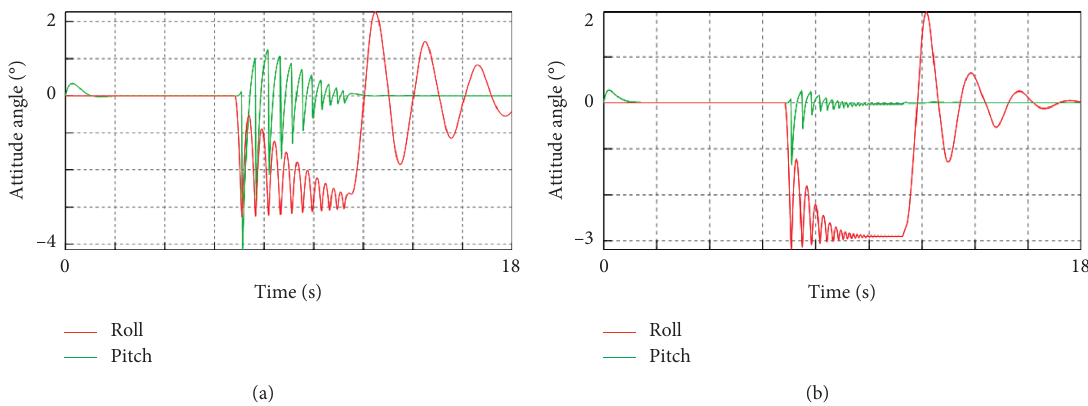
Figure 12: Change of the attitude angle on bend driving under different driving wheel treads. (a) 374 mm. (b) 574